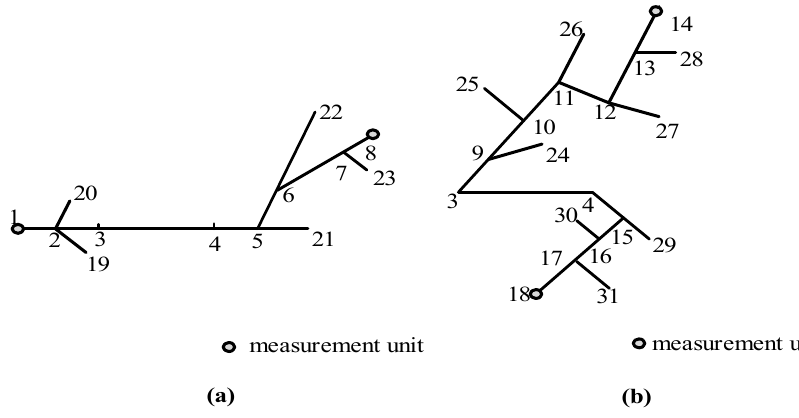
Figure 6. A multi-level branch distribution network.